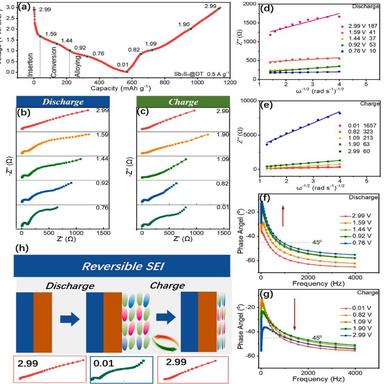
The energy storage mechanism (a) of Sb2S3@DT at different charge/discharge stages. Nyquist plots at the different voltage of discharged (b) and charged (c) process. The linear relations between Z'' and ω− 1/2 of Sb2S3@DT at different discharge(d) and charge (e) stages. The relationships between phase angle and frequency for Sb2S3@DT at different discharge (f) and charge (g) stages. Schematic illustration of the reversible SEI layer formation on the surface of Sb2S3@DT electrode (h).